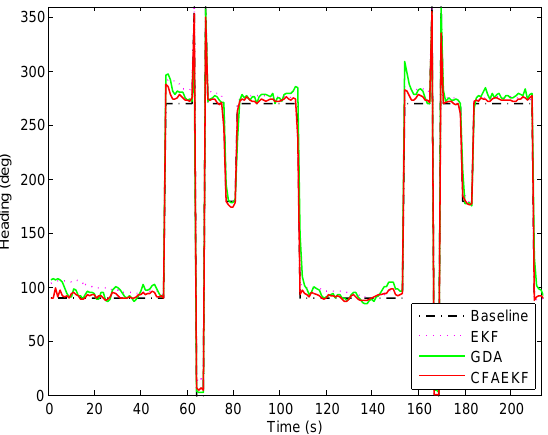
Figure 15. Statistical errors of heading estimation.